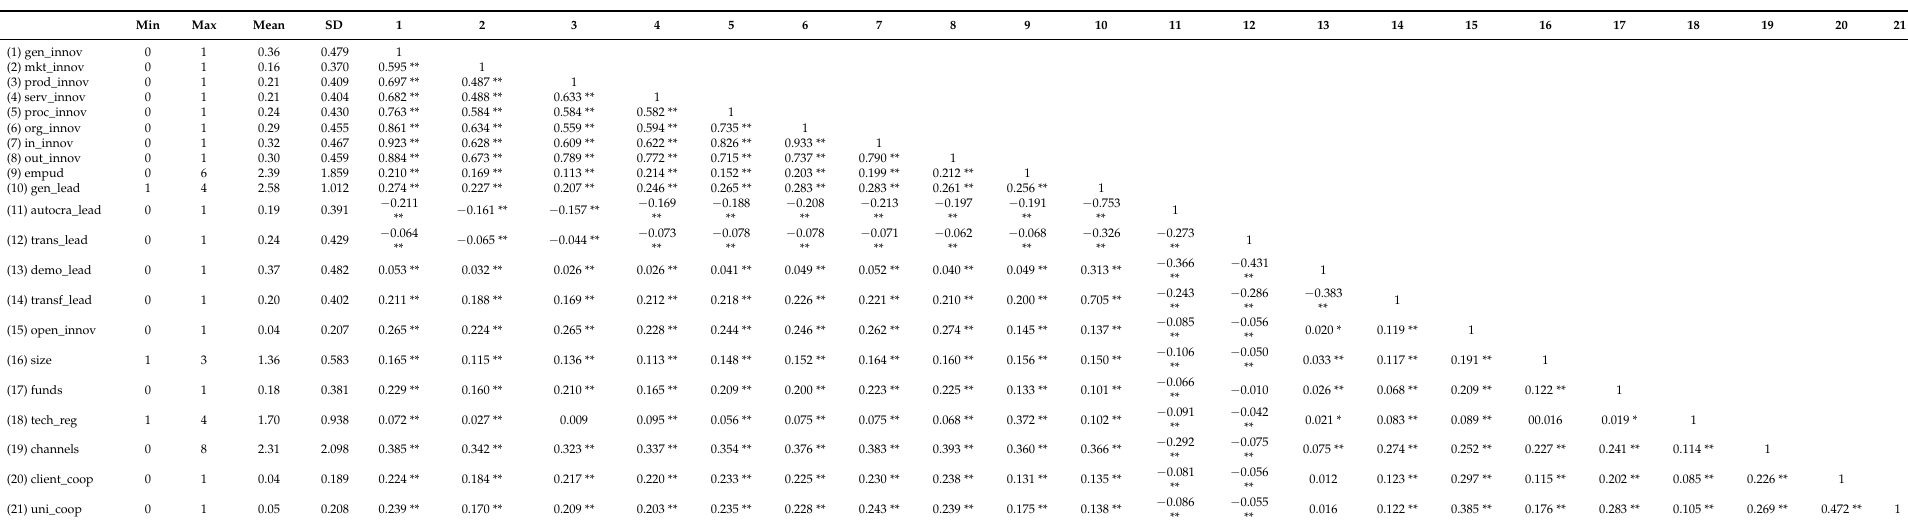
Table 4. Descriptive Statistics and